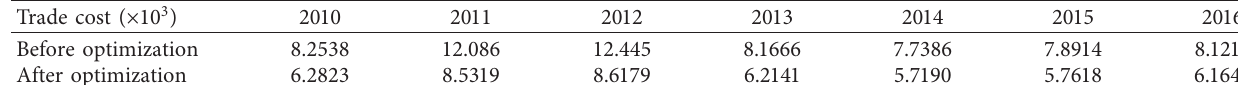
Table 2: The trade costs comparison of preoptimized and optimized crude oil trade.